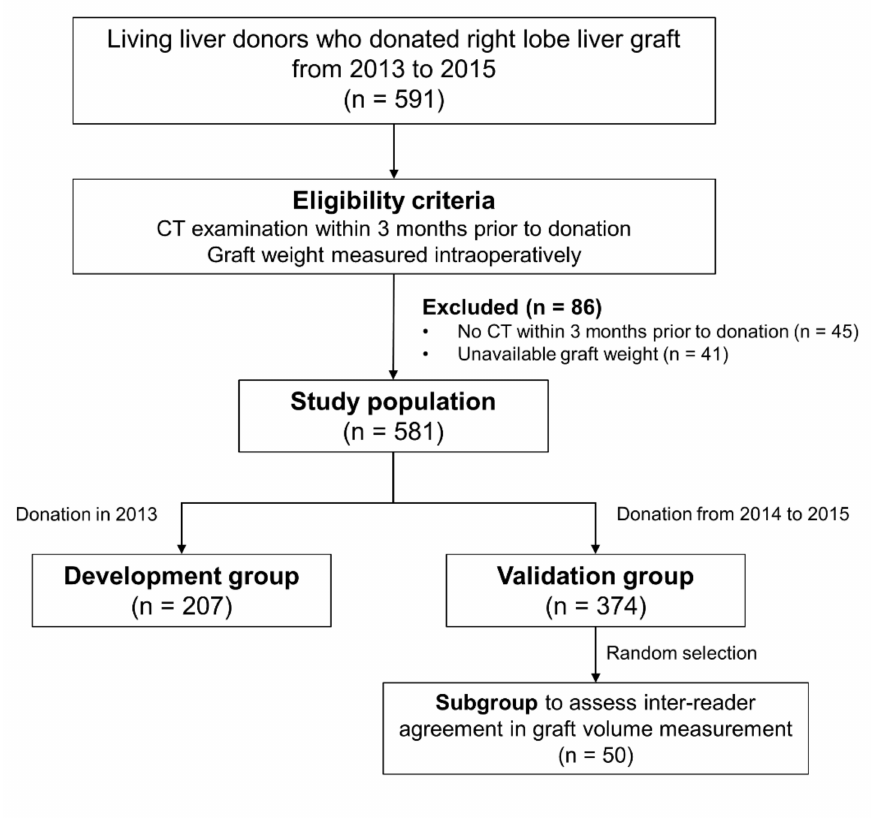
Figure 1. Flow diagram of the study